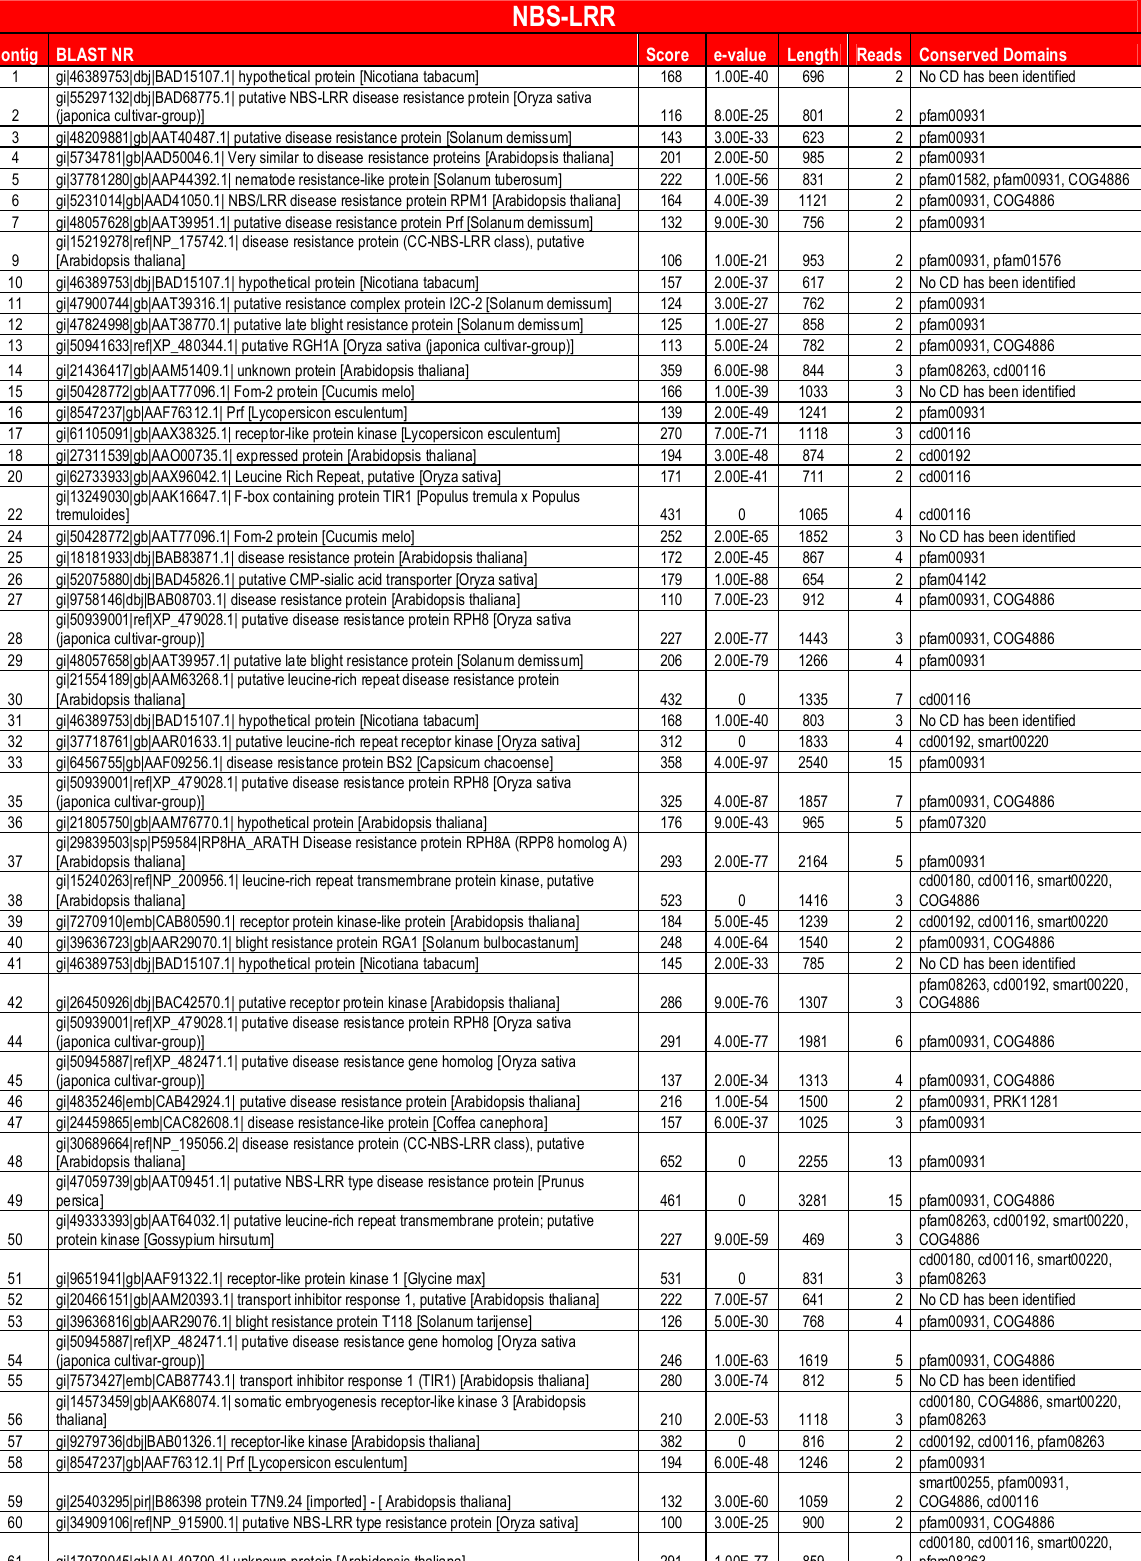
Table S1: EST-Contigs with e-value < e -20 and score > 100 obtained in the Project NBS-LRR, and their blast hit, score, e-value, size, number of reads, and conserved domains from putative proteins. NBS-LRR Contig BLAST